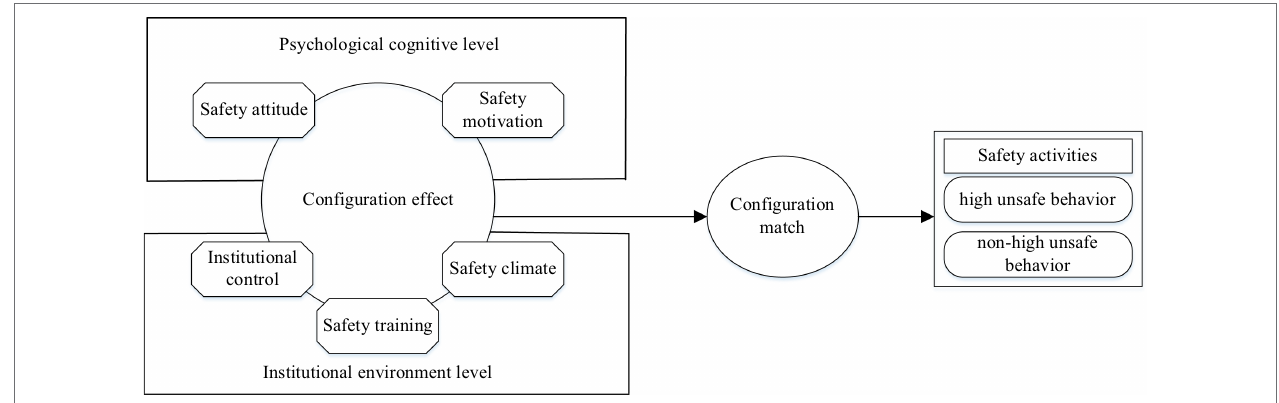
FIGURE 2 | Conceptual model for configuration study of unsafe behavior influence mechanism of construction